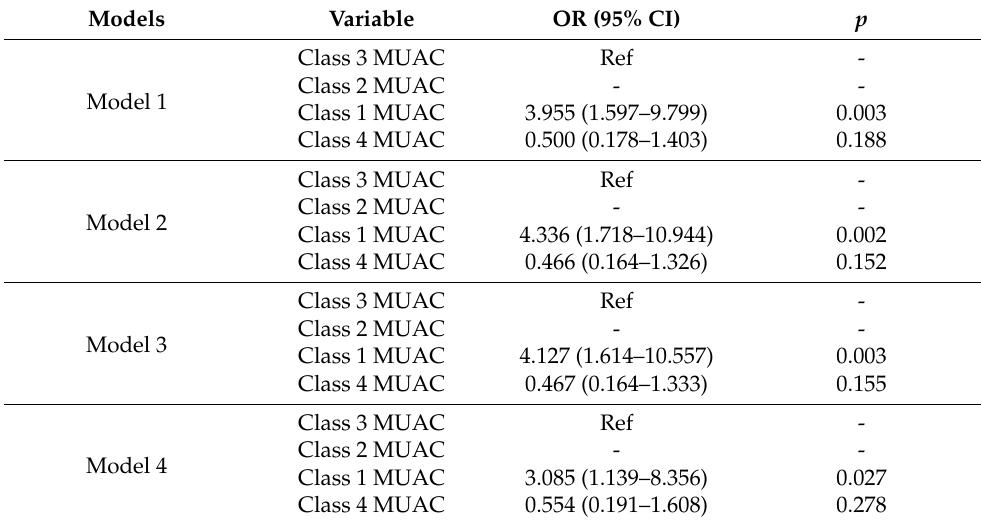
Table 2. The associations between MUAC trajectories and diabetes by logistic